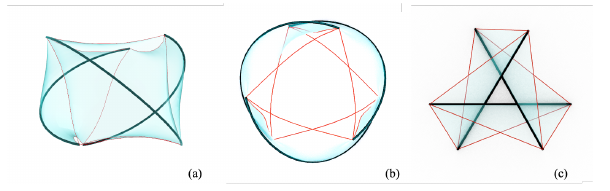
Figure 4: The three types of spring elements considered to model the arches in the stick-and-spring model, associated to edges, wedges, and